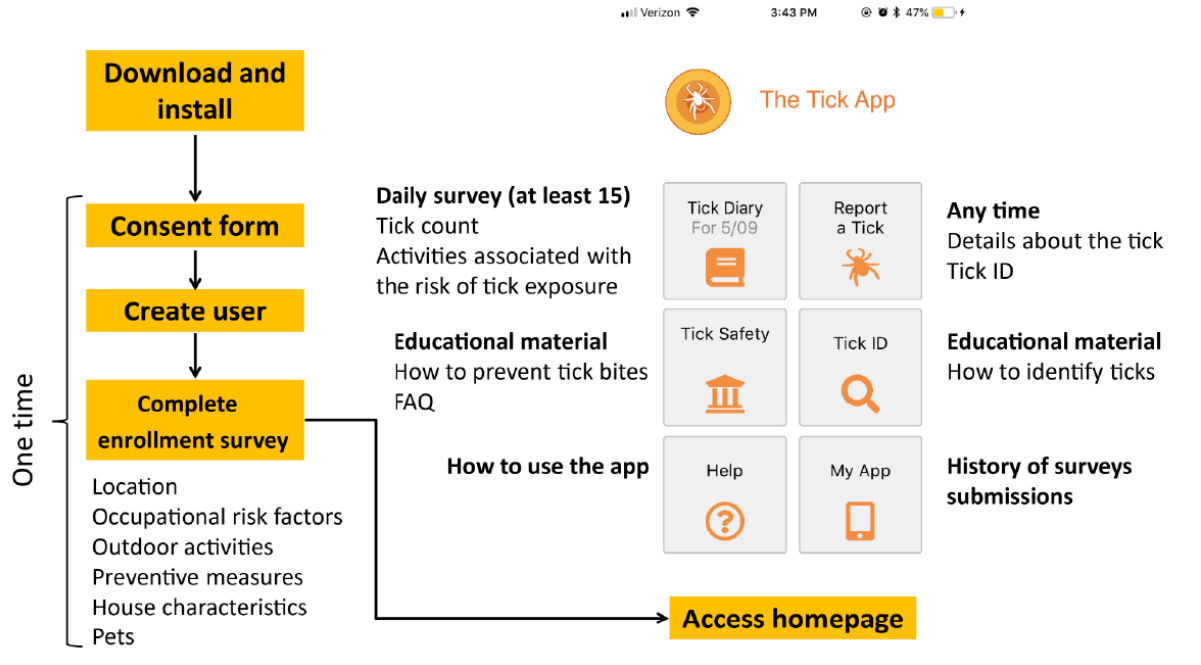
Figure 1. Workflow and homepage of The Tick App. The time frequency for the surveys (Tick Diary and Report a Tick) and the type of content